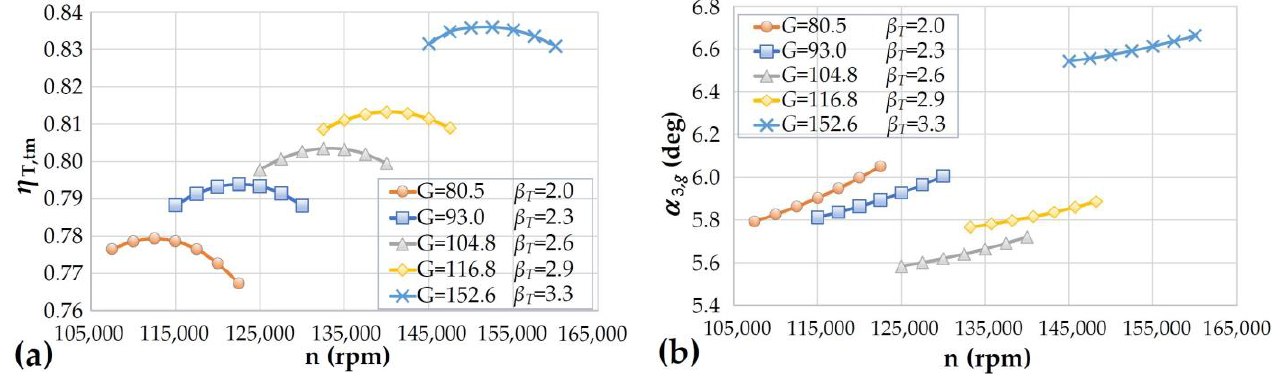
Figure 7. Turbine MFP curves as a function of pressure ratio β T for different positions of nozzle blades.